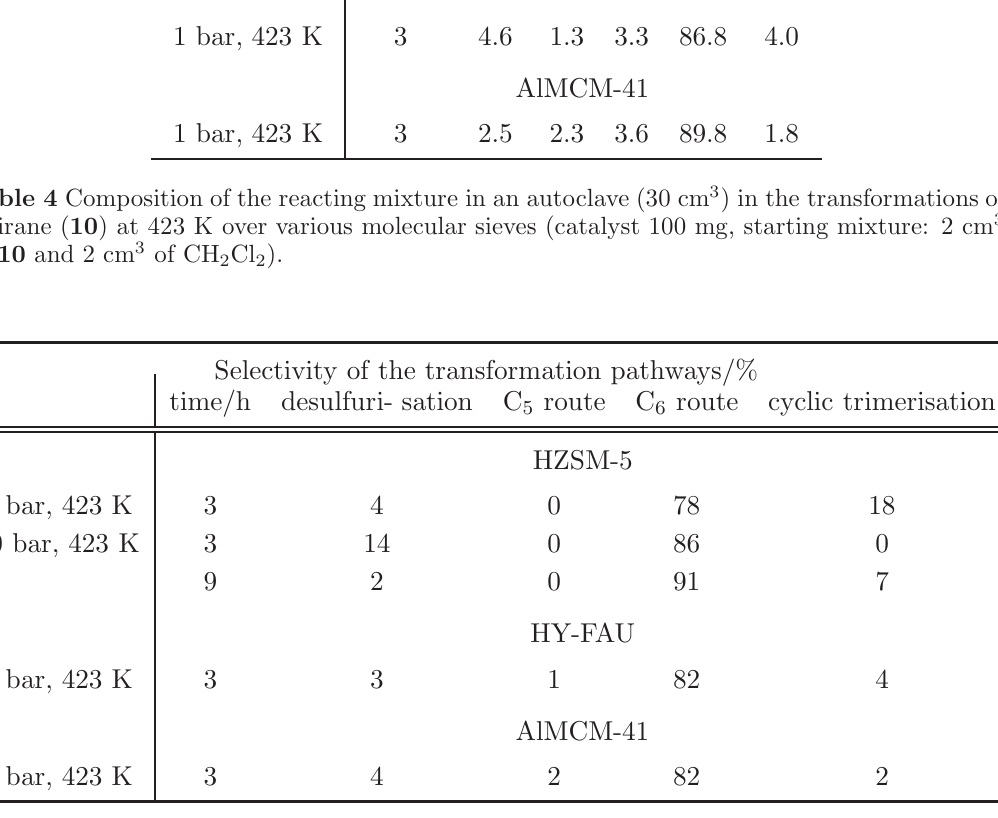
Table 5 Proportions of the reaction channels in the transformations of thiirane ( 10 ) at 423 K over various molecular sieves (catalyst 100 mg, starting mixture: 2 cm 3 of 10 and 2 cm 3 of CH 2 Cl 2